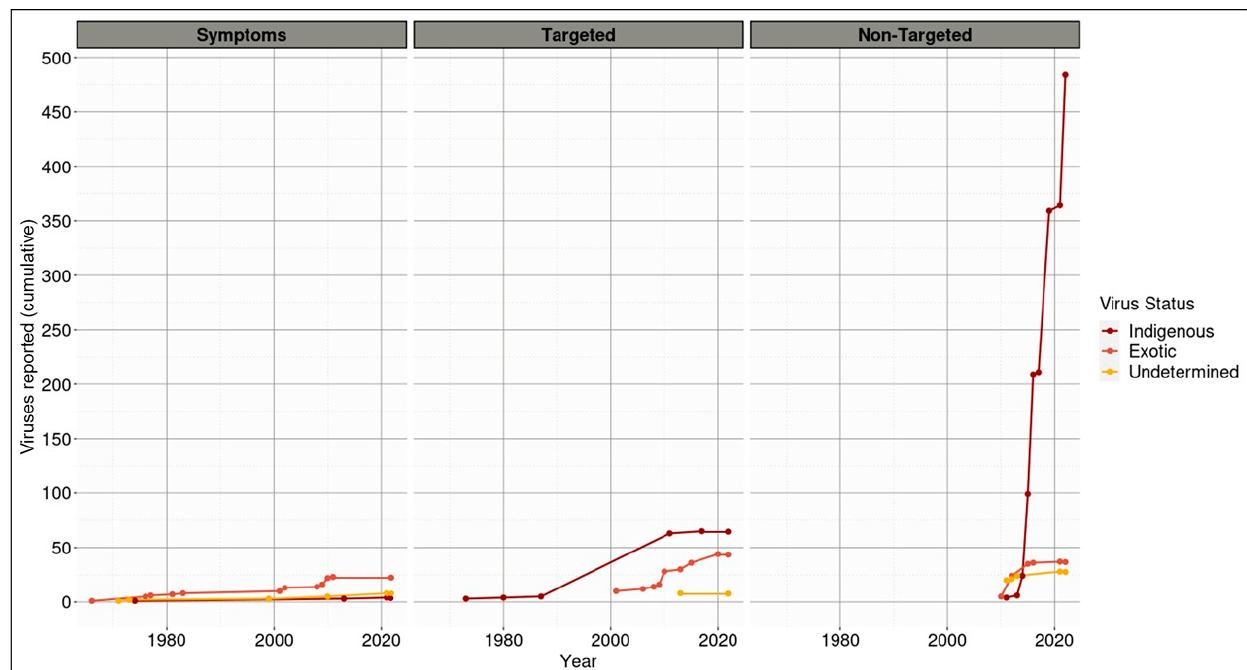
Figure 3. Total number of reported viruses associated with Aotearoa New Zealand indigenous hosts as of February 2022, compared based on virus status and detection method. Virus status is described in Section 2.4.